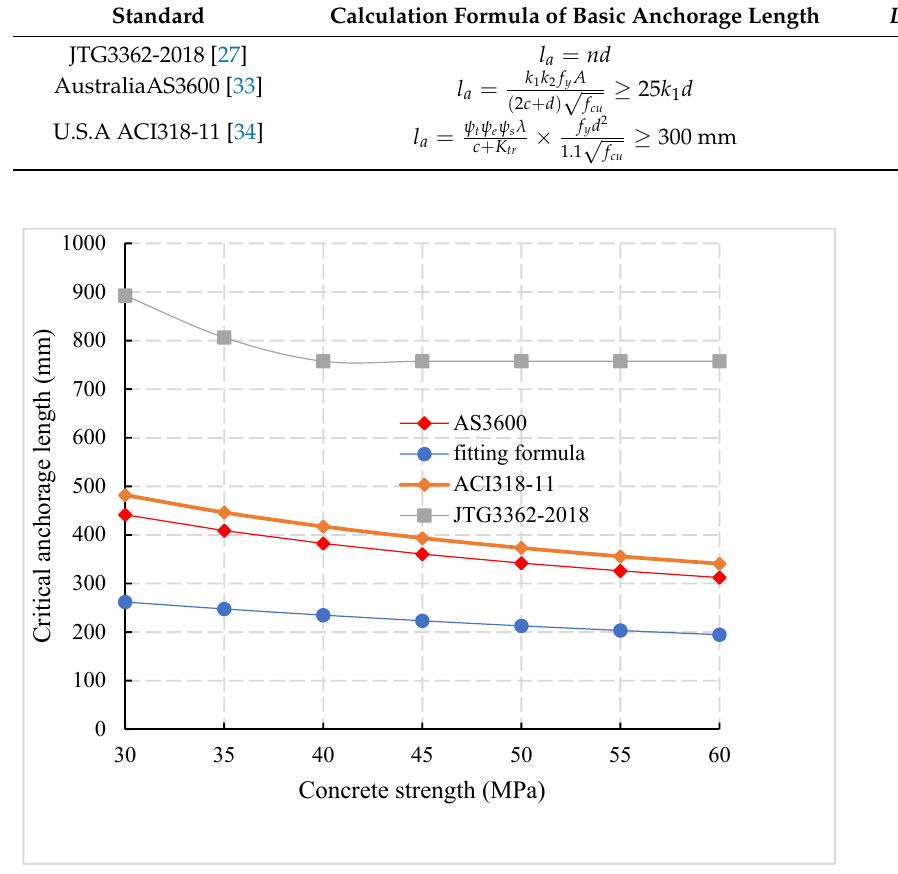
Figure 18. Comparison of critical anchorage length calculation between domestic and foreign codes.